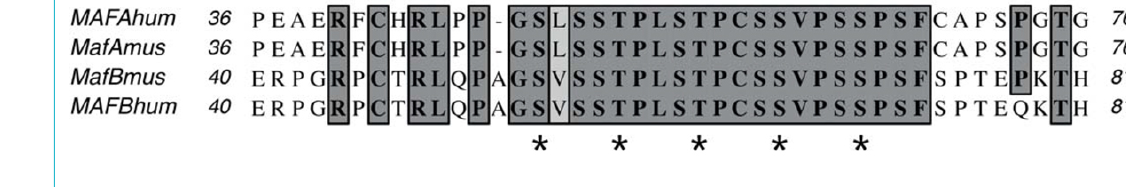
Figure 4: Alignment of the amino acid sequences of MAFA and MAFB from mice and humans at the region that is mutated in MCTO patients. Identical residues are boxed. Serine and threonine residues, which can become phosphorylated by GSK3, are indicated by aster- isks. The mutation of the index patient corresponds to serine-54, which represents the first of the five phosphorylation